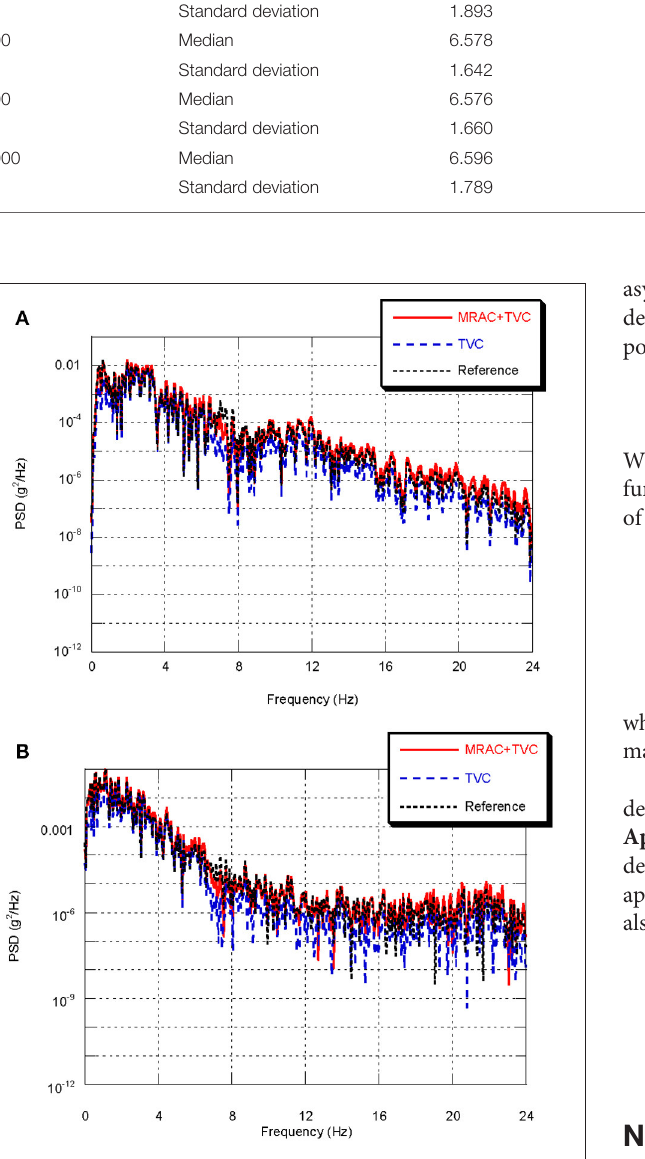
FIGURE 7 | Comparison of table performance in frequency domain. Acceleration power spectral density for (A) Northridge earthquake and (B) Taft